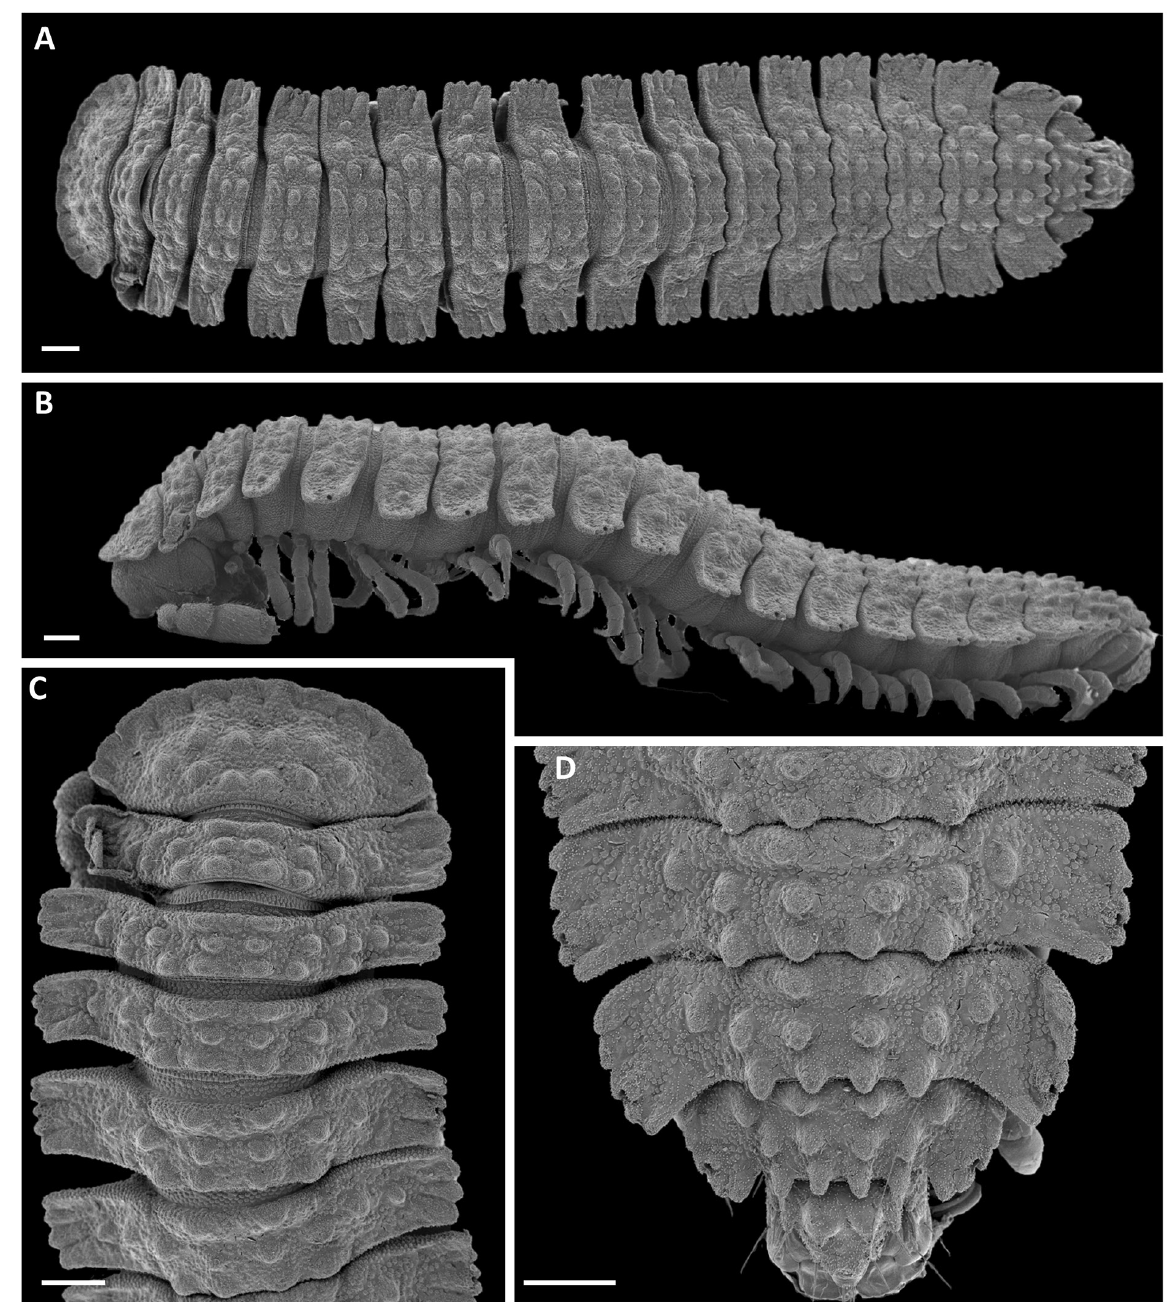
Fig. 1. Cryptocorypha geminiramus sp. nov., paratype (NHMD 621824), ♂, from Kidatu. A . Dorsal view. B . Lateral view. C . Collum and rings 2–6, dorsal view. D . Rings 15 (part)–18 and telson, dorsal view. Scale bars = 0.1